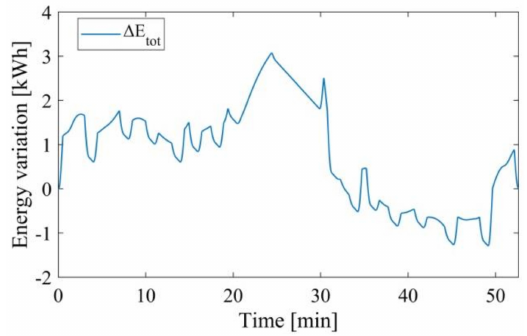
Figure 4. Energy